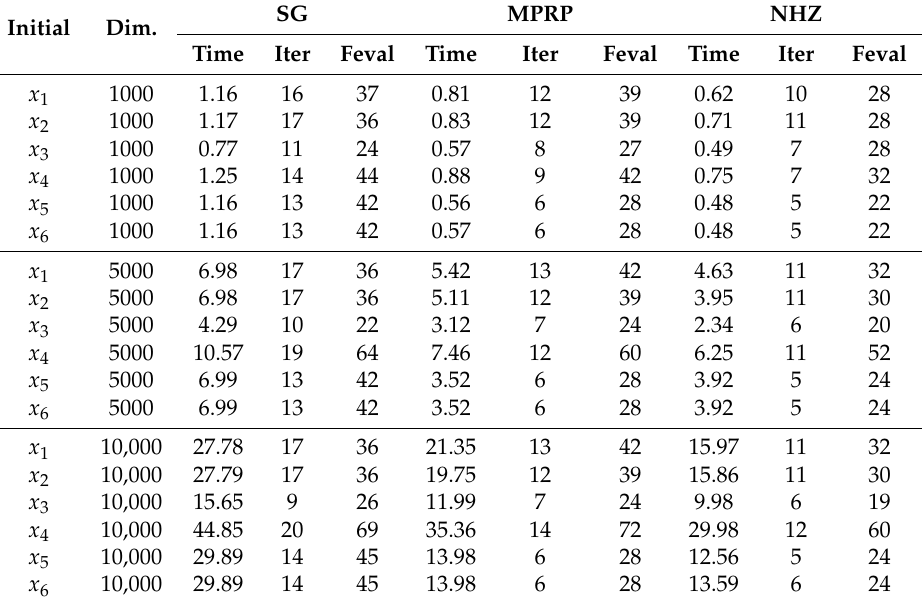
Table 3. Numerical results for the tested Problem 3 with various sizes and given initial points.